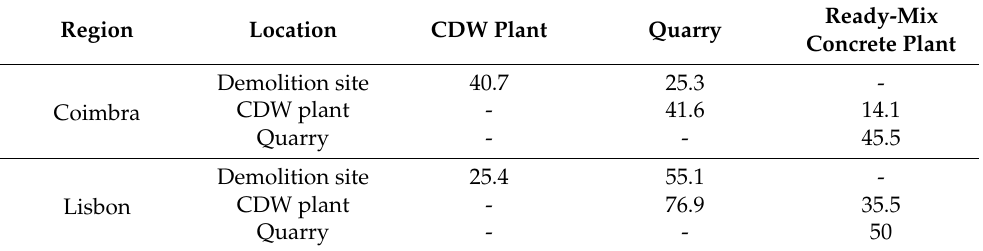
Table 2. Transport of the aggregates and main operations for each scenario.